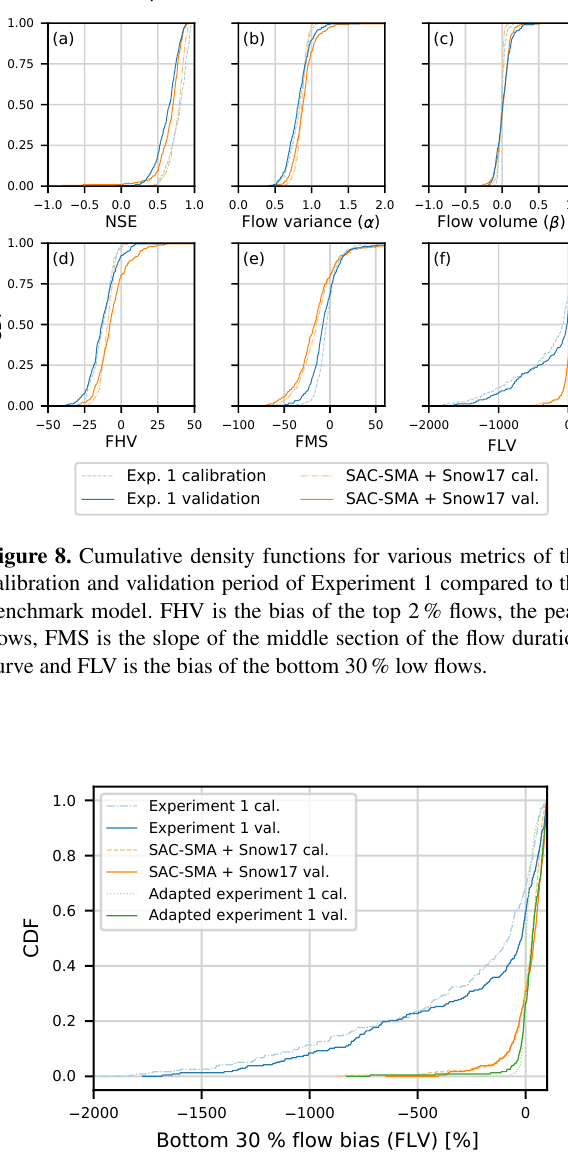
Figure 9. The effect of limiting the discharge prediction of the net- work not to zero (blue lines) but instead to the minimum observed discharge of the calibration period (green lines) on the FLV. Bench- mark model (orange lines) for